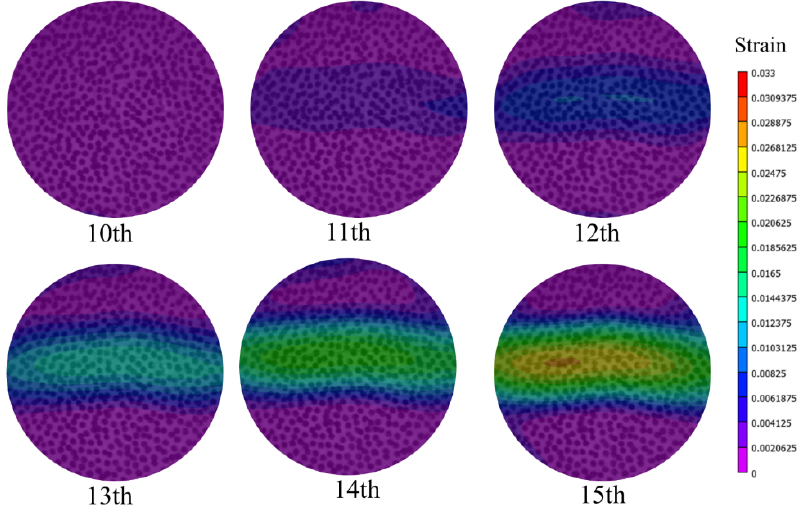
Figure 12. Strain variation diagram of concrete specimen without a turning point in the load–time curve.